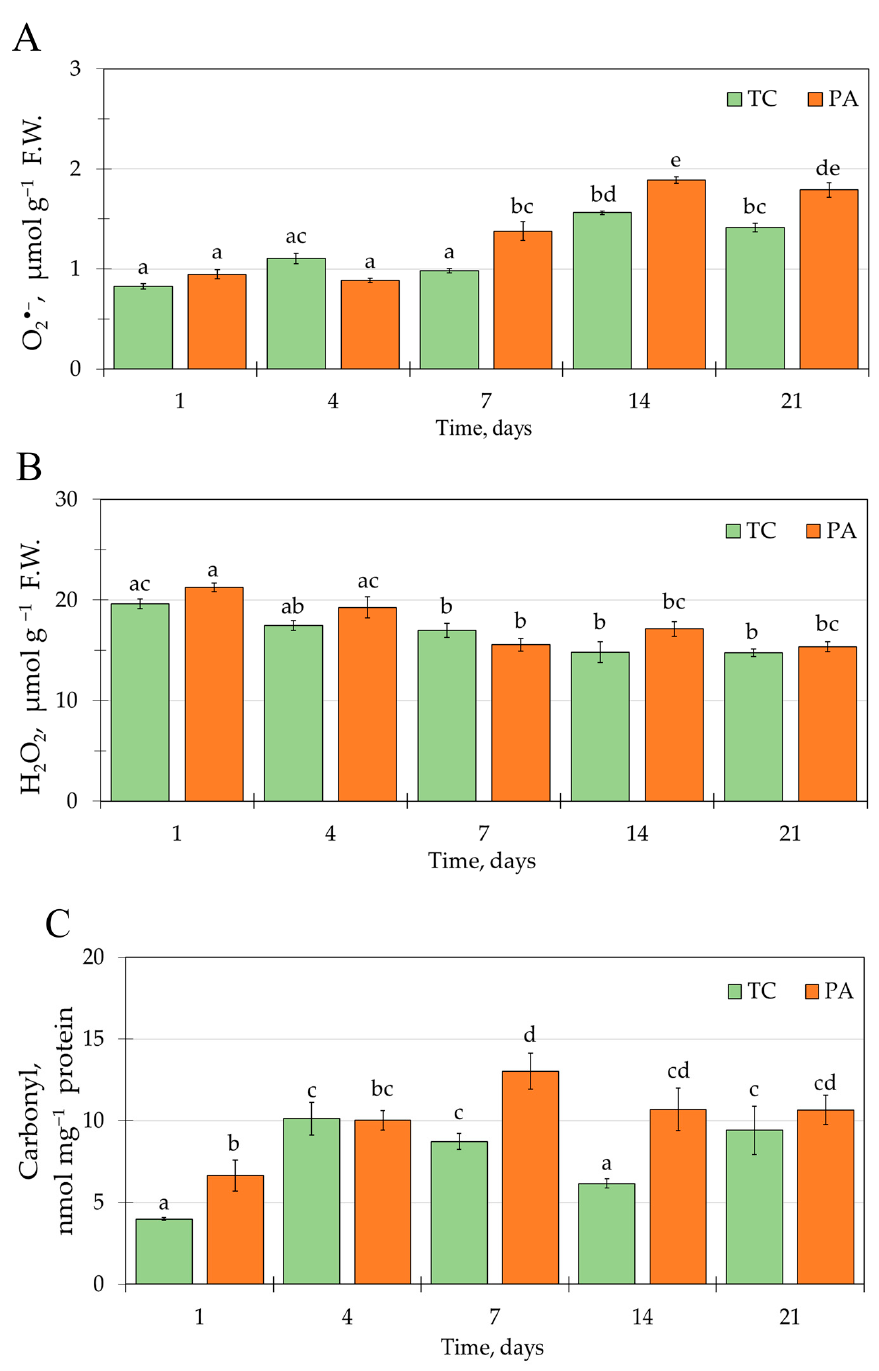
Figure 1. Variation of O 2 •− ( A ), H 2 O 2 ( B ), and carbonyl ( C ) content in control (TC) and timentin- treated (PA) tobacco shoot tissues during the propagation cycle. Time scale is presented as days after shoot transfer to fresh medium; data are presented as the mean ± standard error of the mean; different letters denote significant difference between the mean values ( p < 0.05).